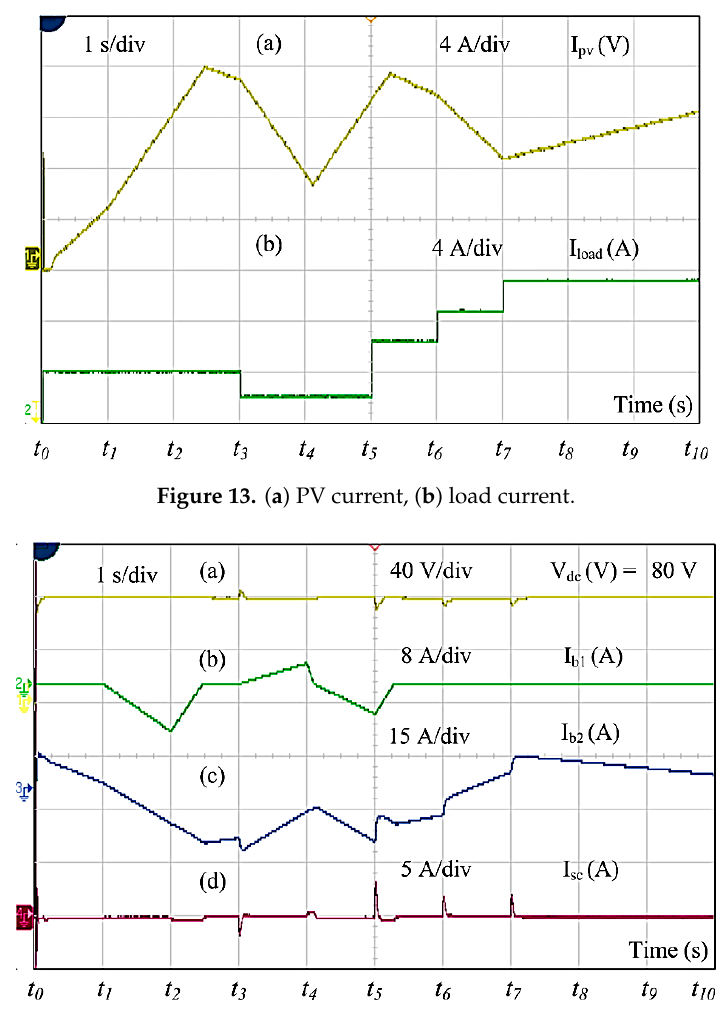
Figure 14. ( a ) DC link voltage, ( b ) battery-1 current, ( c ) battery-2 current, ( d ) super-capacitor (SC)